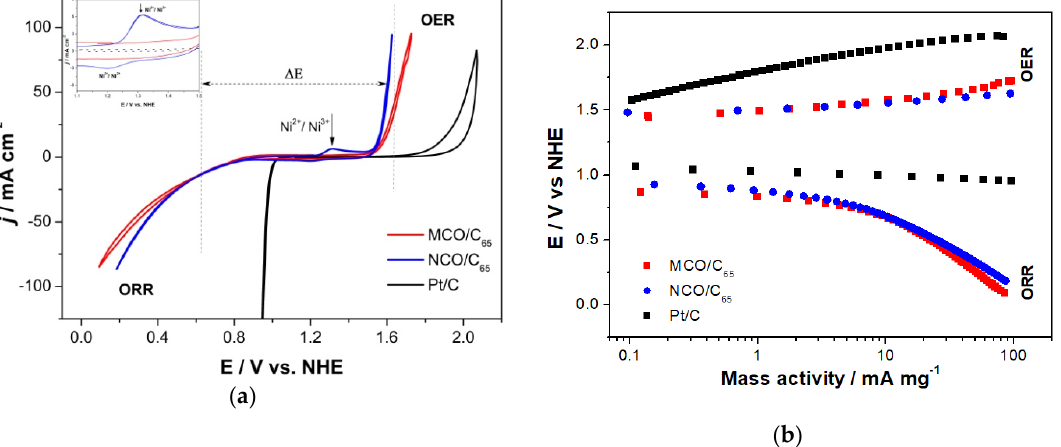
Figure 7. ( a ) CV of 1 mg catalyst cm − 2 as-prepared MCO and NCO based GDEs and commercial Pt/C GDE at 5 mV s − 1 in O 2 -saturated 7 M KOH. ( b ) Corresponding semi-logarithmic Tafel plots in ORR/OER